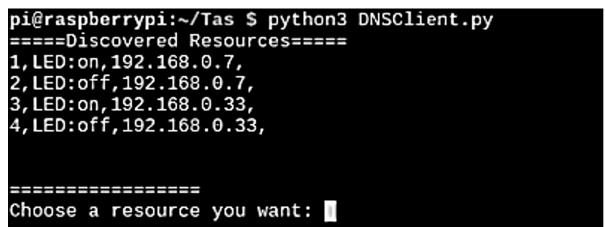
Figure 14. Example of the oneM2M client interface.